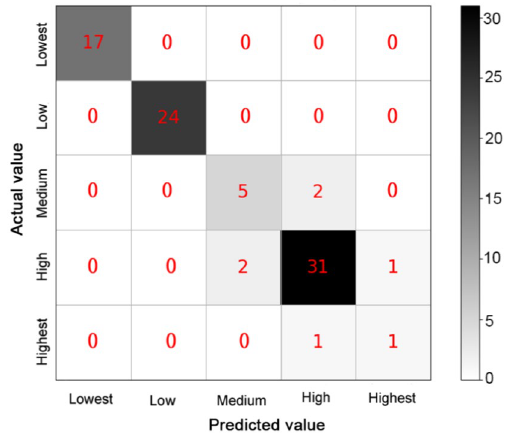
Fig. 4 Neural network model of the vulnerability of immovable cul- tural relics Fig. 5 Confusion matrix of the back propagation (BP) neural